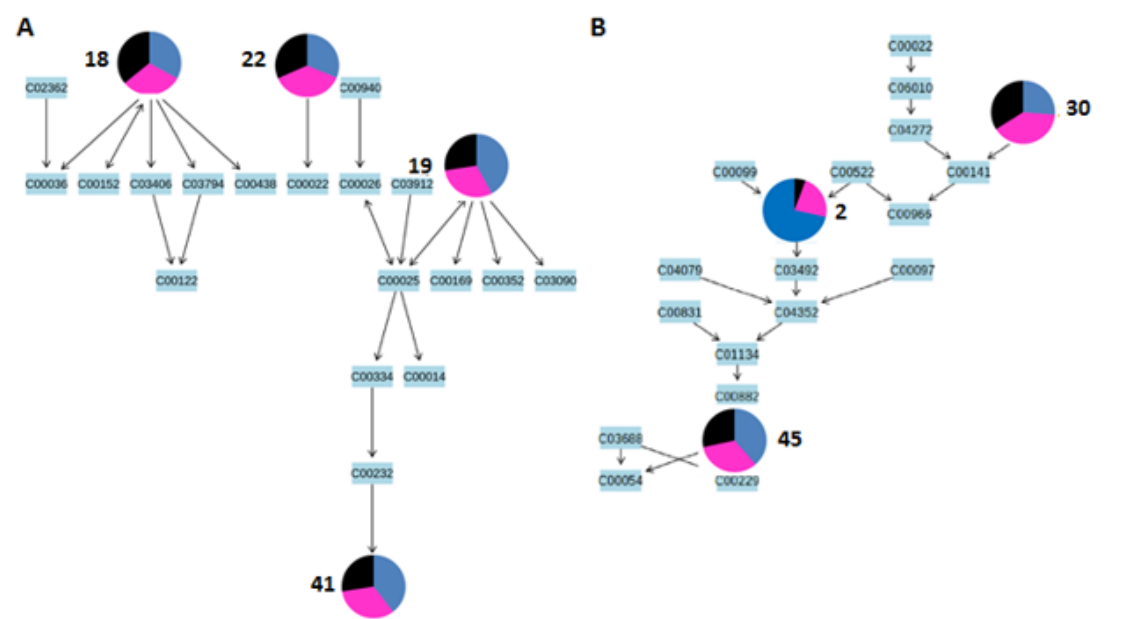
Figure 5. Metabolomics pathway topology analysis. A visual representation of information showing ( A ) alanine, aspartate, and glutamate metabolism, and ( B ) pantothenate and coenzyme A pathways displaying some tentatively annotated metabolites found to be present in H. roseonigra . Annotated metabolites participating in the pathways are pantothenic acid ( 2 ), L-aspartate ( 18 ), glutamine ( 19 ), valine ( 20 ), alanine ( 22 ), succinate ( 41 ), and CoA ( 45 ). The charts represent the relative concentration across the growth/developmental stages (Blue = early, Pink = log, Black = stationary). The figure only represents the metabolites that could be mapped using the MetPA tool.